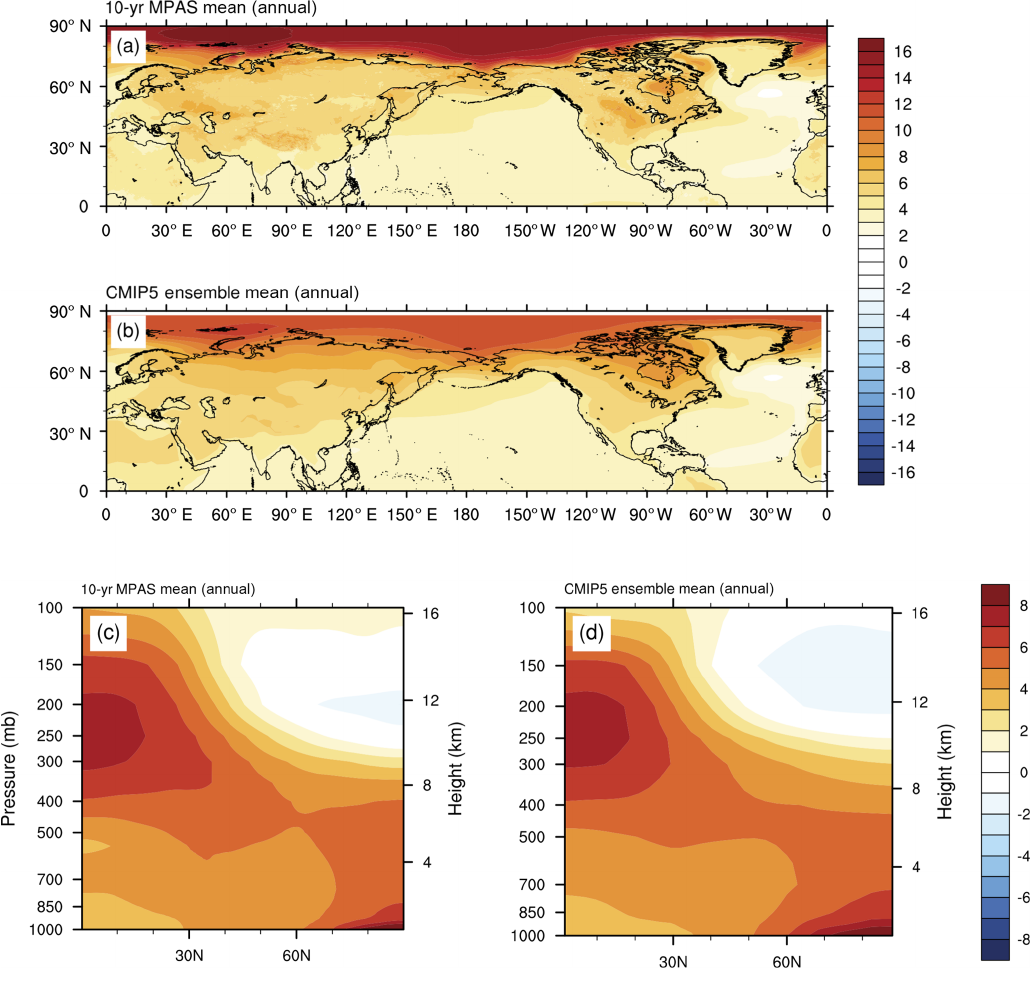
Figure 11. (a, b) Average annual 2m temperature difference (K; future minus current) for the (a) MPAS-A simulations and (b) CMIP5 GCM ensemble mean. (c, d) Average annual difference cross-section of zonal mean temperature (K; future minus current) for the (c) MPAS-A simulations and (d) CMIP5 GCM ensemble mean. Contours are shaded every 1K in all